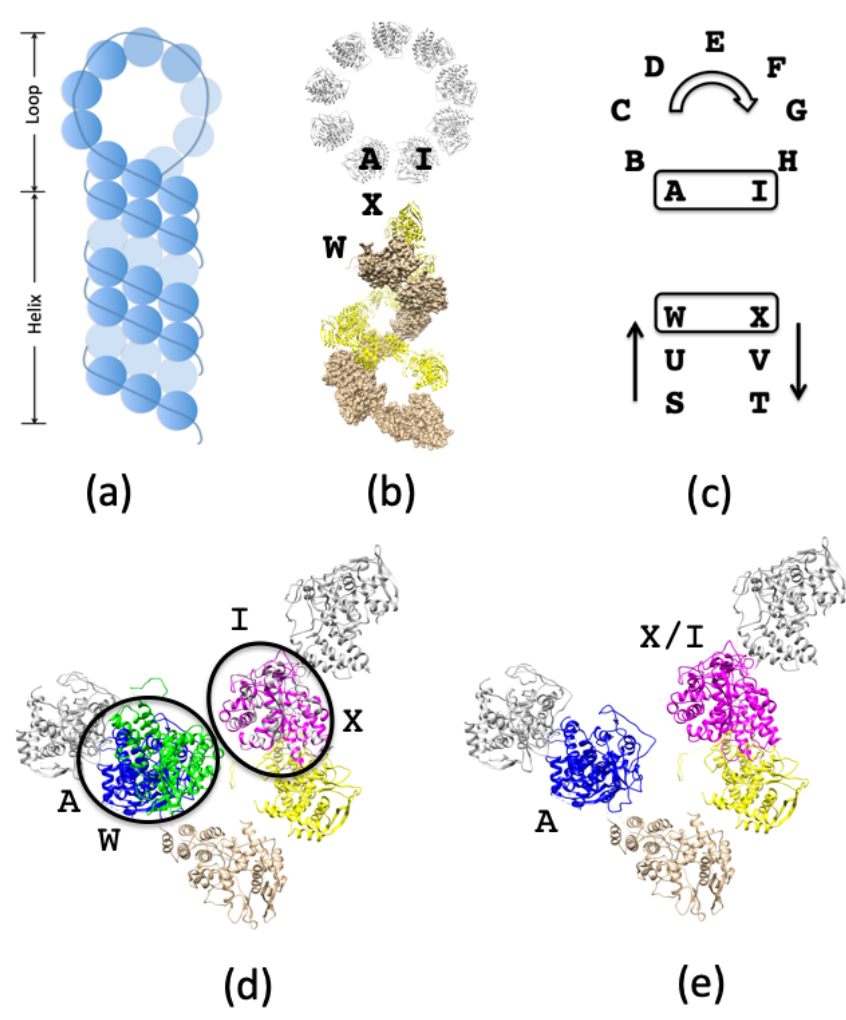
Figure 3. RNP complex. ( a ) The hairpin model of RNP is composed of two arrangements of NP oligomers ( b ): circular (gray) and helical (brown, yellow) suprastructures. ( c ) The two suprastructures (PDB accession codes: 2WFS, 4BBL) are mapped onto one another using two NPs in each structure (circular: A& I, helical: W& X). ( d ) After overlaying these NPs, one NP from each suprastructure is retained in the final model. ( e ) The close alignment of NP-X and NP-I means that either can be selected for the full RNP model. However, due to the orientations of the folded domain from NP-U and the binding pocket of NP-B, only NP-A can form a link between both NPs and unite the two